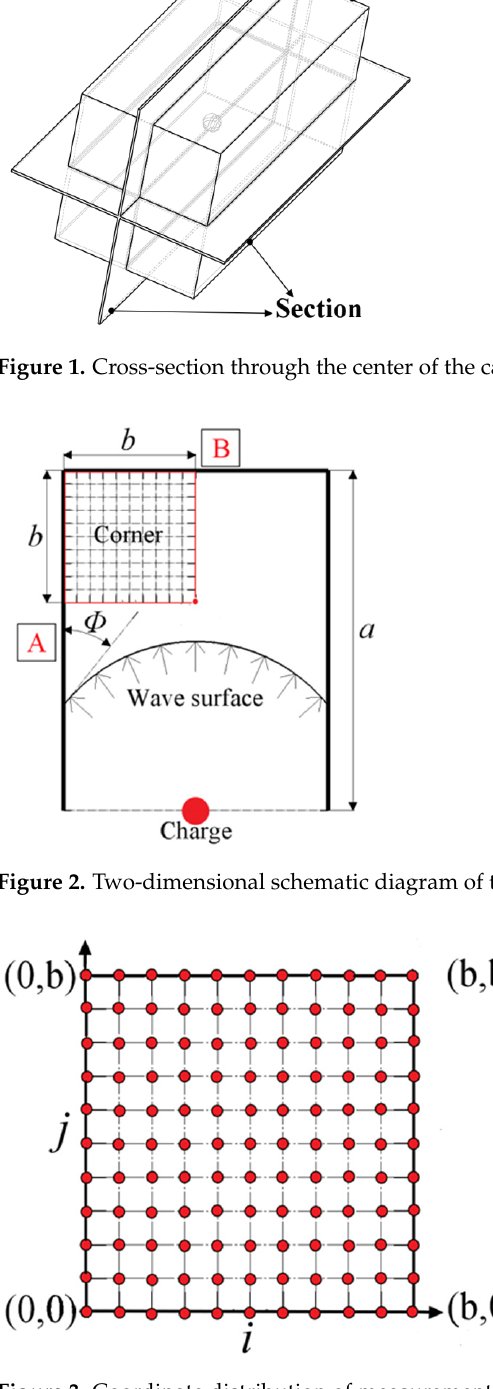
Figure 3. Coordinate distribution of measurement points. The simulation model was run using AUTODYN-2D. The eulerian unit was used for air and the explosives were packed into the air unit. The initial rigid boundary conditions in AUTODYN are adopted for the air boundary to establish a 2D symmetrical model, as shown in Figure 4. The finite element model uses 0.5 mm × 0.5 mm mesh.